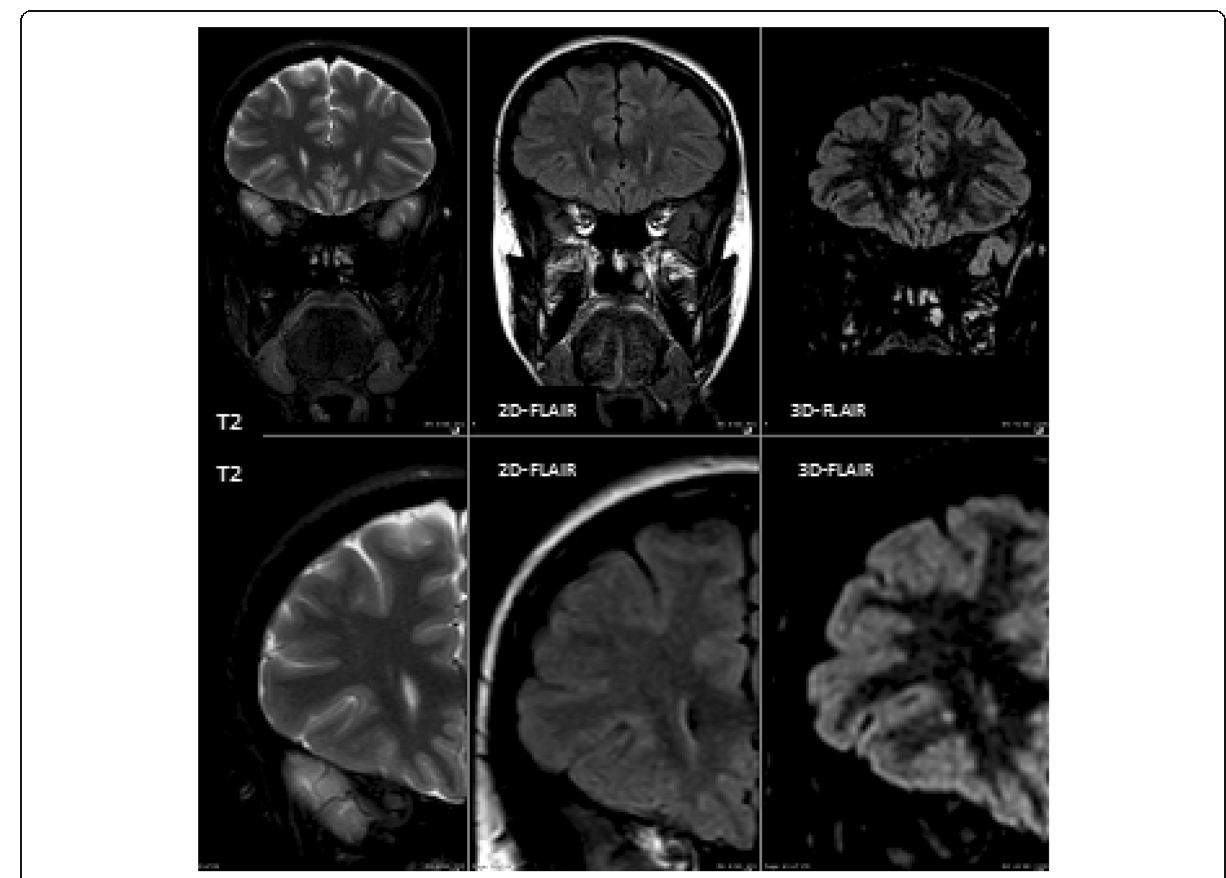
Fig. 5 Above row coronal T2, 2D FLAIR, and 3D-FLAIR image and below row is detail enlargement approximately corresponding to above images in the same patient of Fig. 3 showing single small hyperintense lesions seen in juxta-cortical white matter seen on 3D-FLAIR and not depicted on T2 and 2D-FLAIR